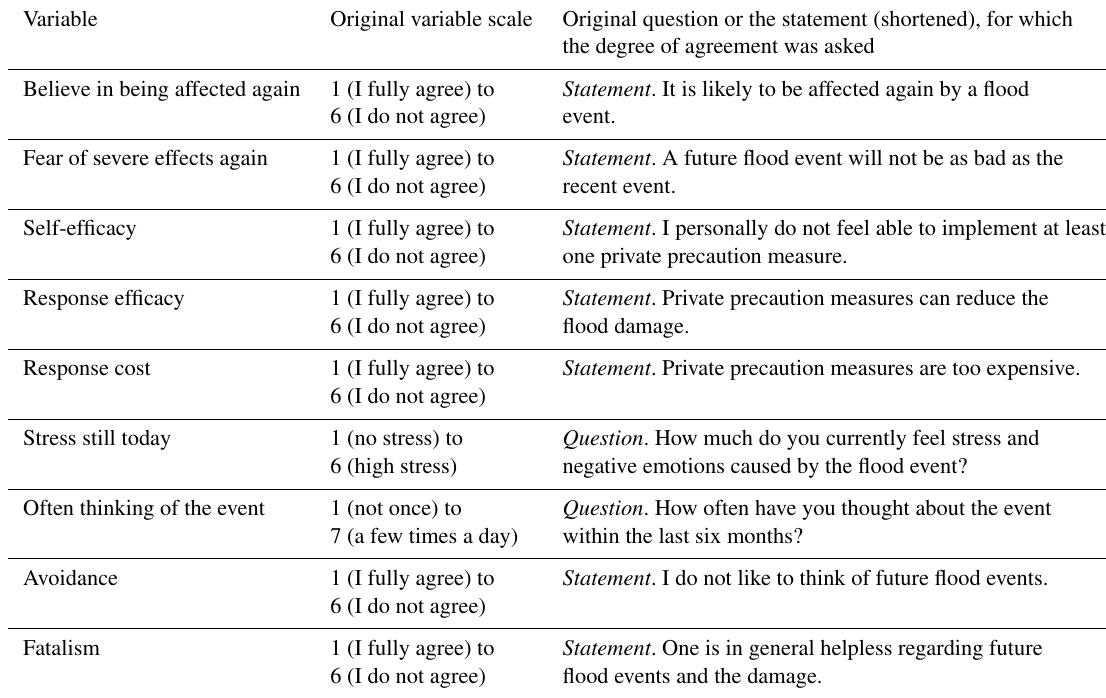
Table 1. List and explanation of the psychological variables used in this study.